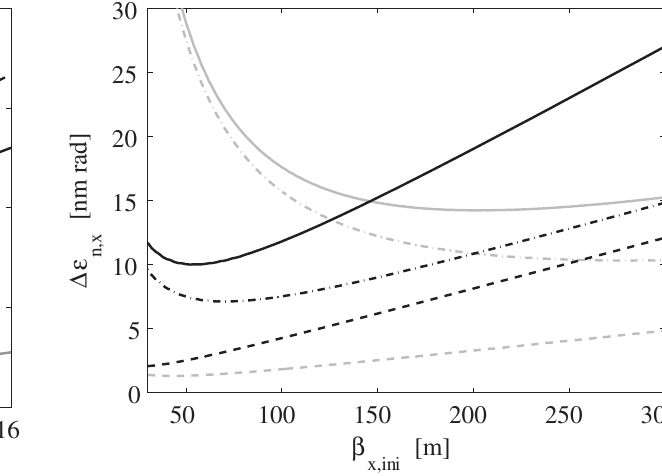
FIG. 10. Variation of minimum ISR (gray), CSR (black), and ISR (cid:5) CSR (dashed) emittance growth with the length of the central drift of an